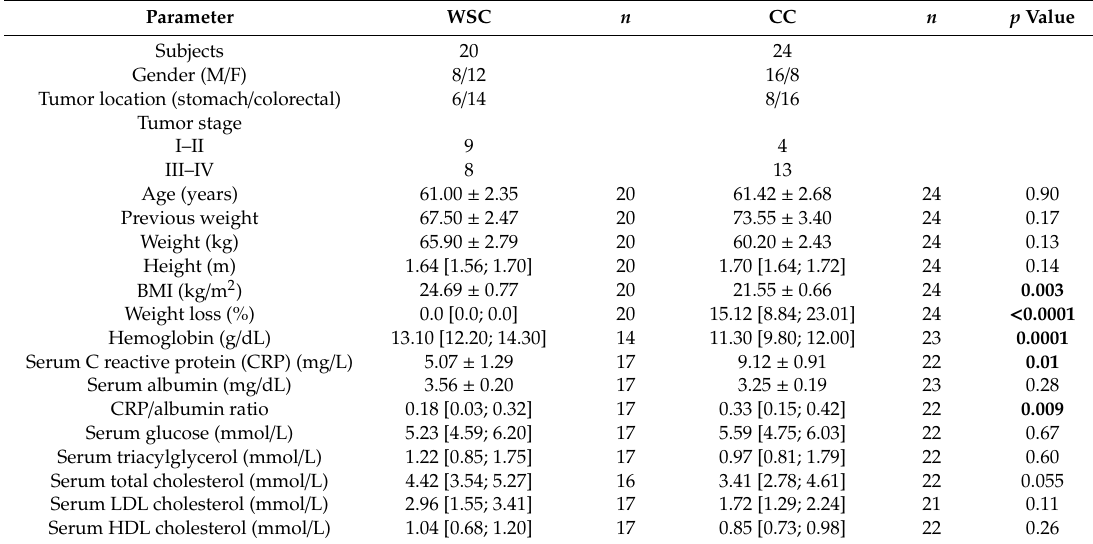
Table 1. Characteristics and circulating biochemical parameters of WSC and CC patients. Parameter